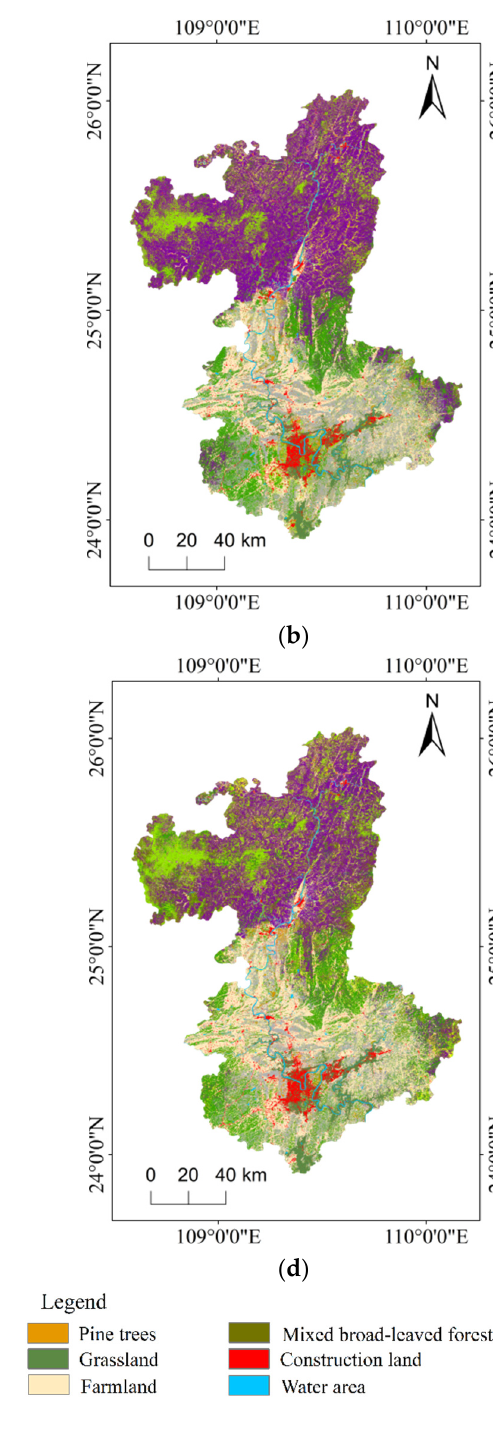
Figure 8. Spatial distribution of the classification results of the different classification methods: ( a ) RF; ( b ) GTB; ( c ) SVM; ( d ) CART.